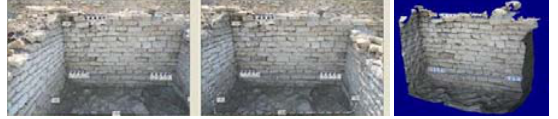
Figure 9. Canon EOS 5D with 28mm focal length: stereopair (left) and 3D textured model from matching